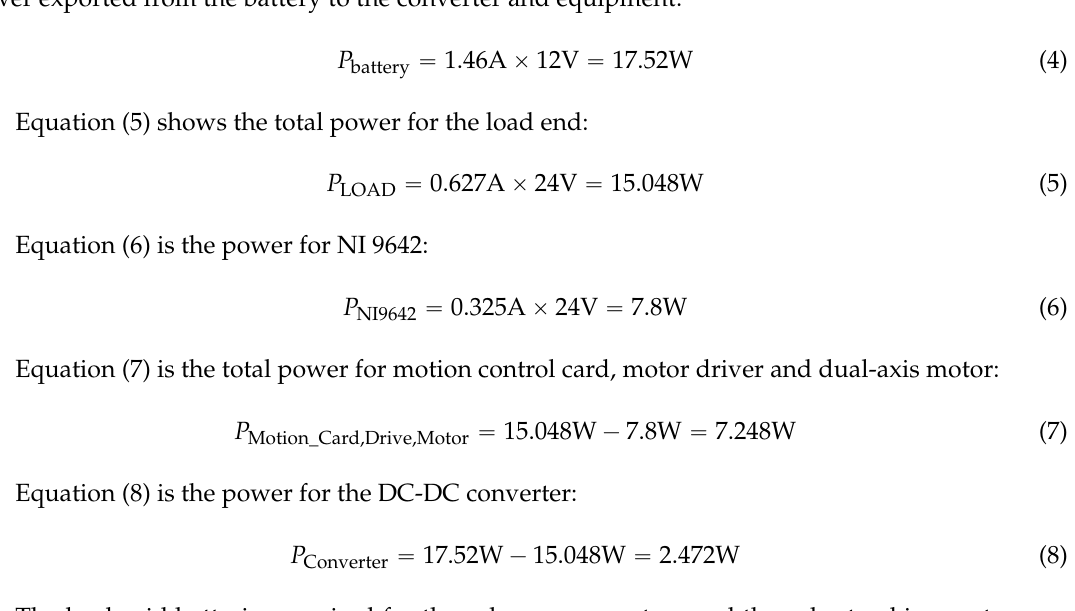
Figure 9. Schematic diagram of battery operation.